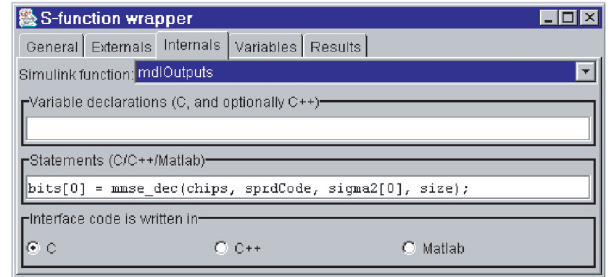
Figure 15: The GUI used to specify a C function call which im- plements an MMSE detector when “wrapping” the detector into a Simulink block. It implements the concepts discussed in Section